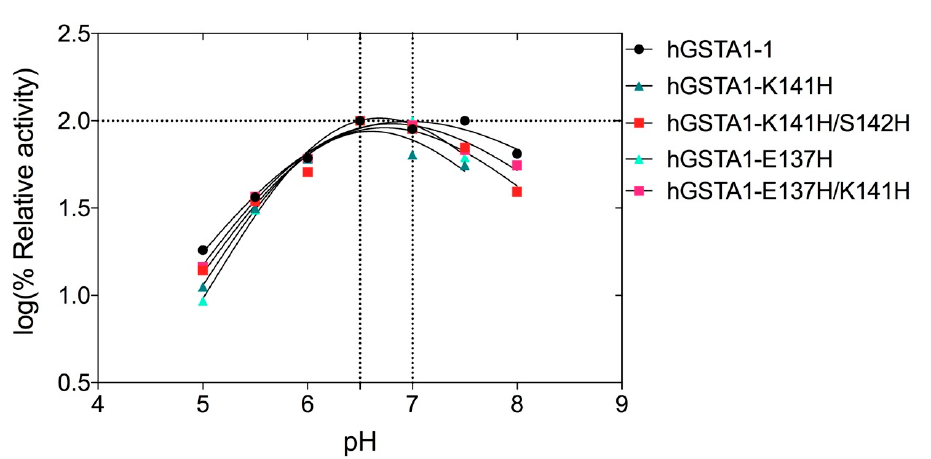
enzyme. In contrast, hGSTA1-K141H/S142H depicted an increase in the T 1/2 value by approximately 4 ◦ C (T 1/2 53.4 ± 0.2 ◦ C), suggesting that the double mutant hGSTA1- K141H/S142H displayed higher thermal stability.